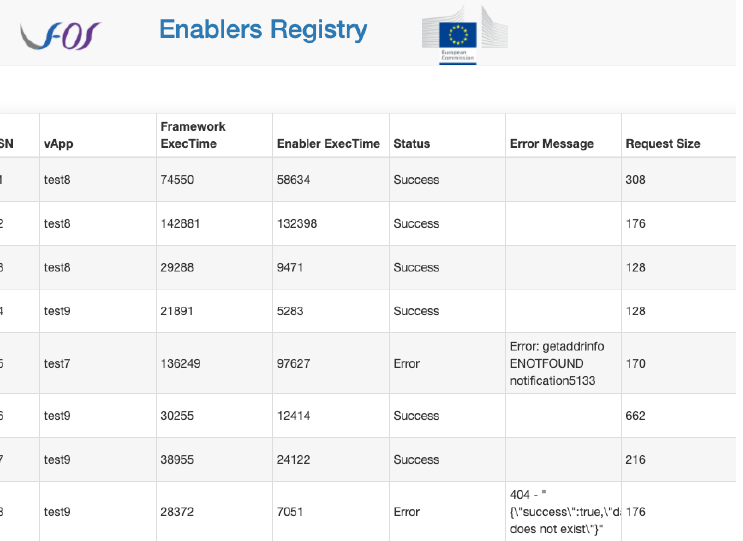
Figure 8. Measurements of enabler services through quantifiable and countable